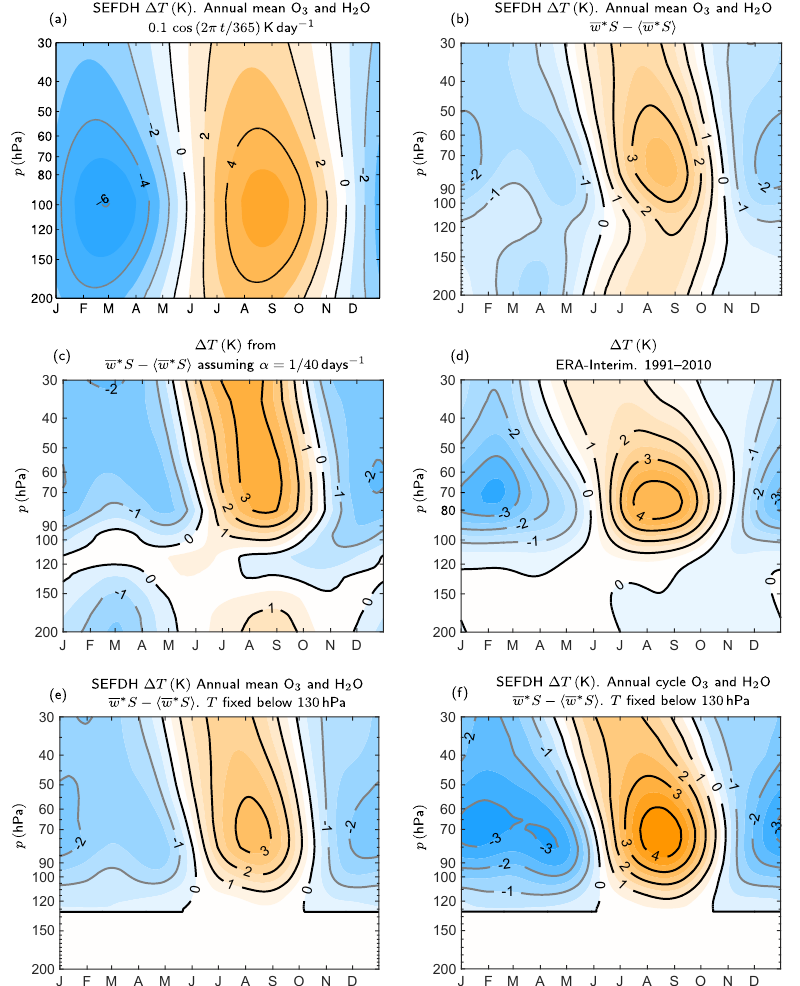
Figure 9. Temperature change from the annual mean averaged between 20 ◦ N and 20 ◦ S. (a) An SEFDH-like calculation with a perturbation of − 0 . 1 cos ( 2 π t/ 365 ) Kday − 1 is added to the dynamical heating with annual mean ozone and water vapour. (b) The temperature change from the annual cycle in the ERA-Interim dynamical heating, w ∗ S −(cid:104) w ∗ S (cid:105) , shown in Fig. 8c. (c) Temperature change due to the annual cycle in the ERA-Interim dynamical heating but assuming a constant radiative relaxation rate of 1 / 40 days − 1 . (d) ERA-Interim annual mean temperature averaged between 1991 to 2010 (same as Fig. 1a). (e) Similar to (b) but with temperature held fixed at the annual mean below 130hPa. (f) Similar to (e) but with the additional perturbation from the annual cycle in ozone and water vapour